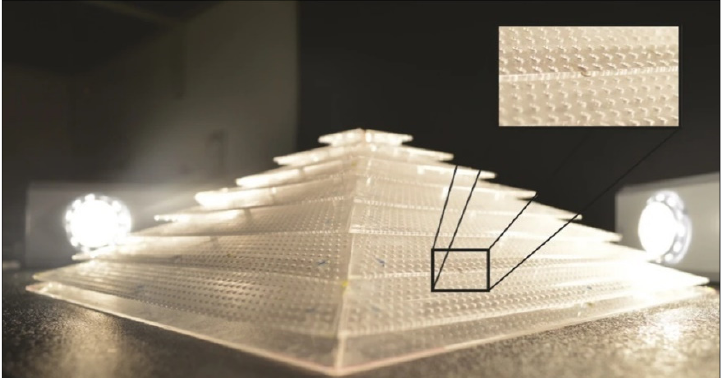
Figure 2. Omni-directional 3D acoustic cloak manufactured using 3D printing (cloak operational for acoustic waves at a frequency of 3 kHz) [57]. (Reprinted by permission from Springer Nature: [Nature Materials, ‘Three-dimensional broadband omnidirectional acoustic ground cloak’, L. Zigoneanu et al., 2014]).